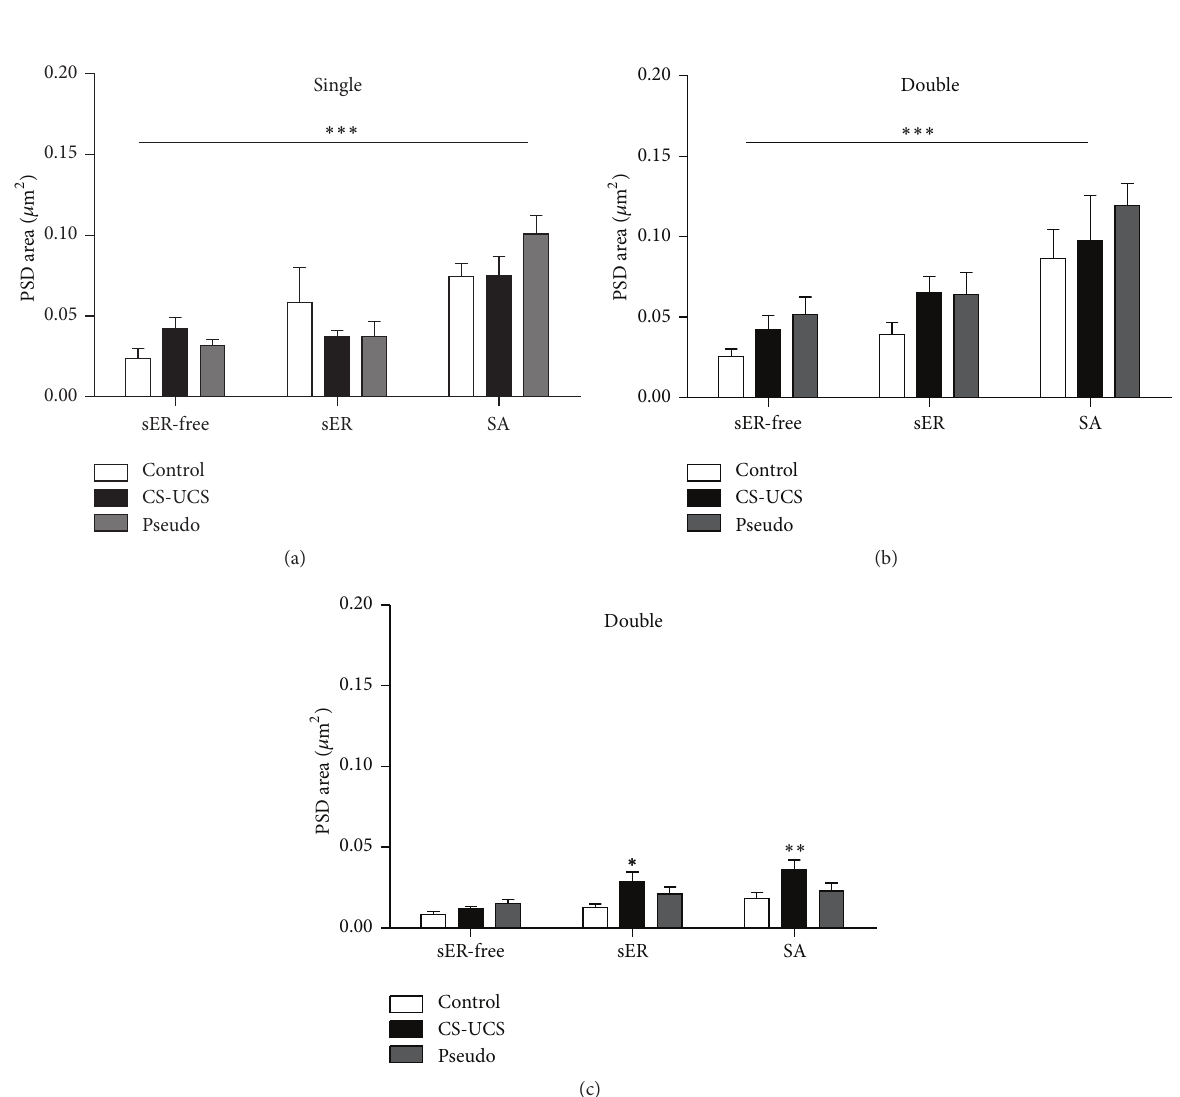
control group (sER: 0.27 ± 0.03/ 𝜇 m 3 , SA: 0.16 ± 0.02/ 𝜇 m 3